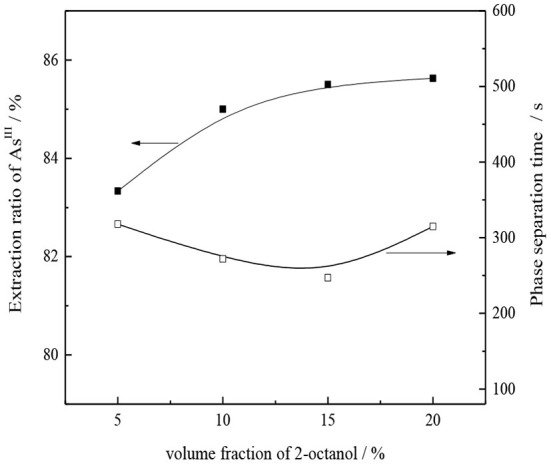
Effect of volume fraction of 2-octanol on AsIII extraction and phase separation.